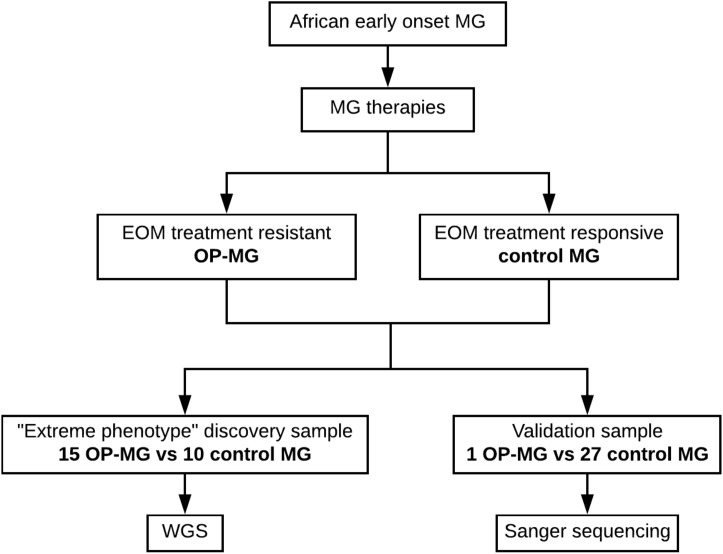
Schematic of study design showing discovery and validation samples.